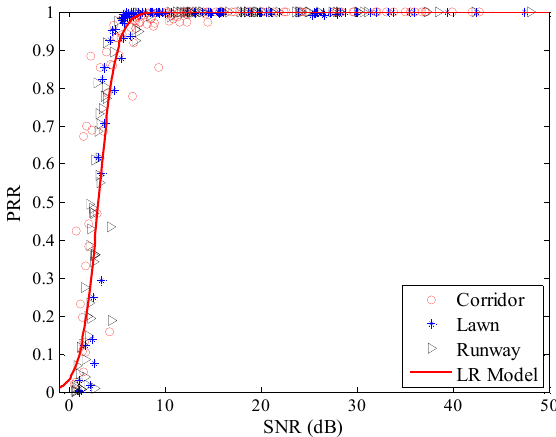
Figure 18. E ff ects of the LR model in di ff erent Figure 18. Effects of the LR model in different environments.